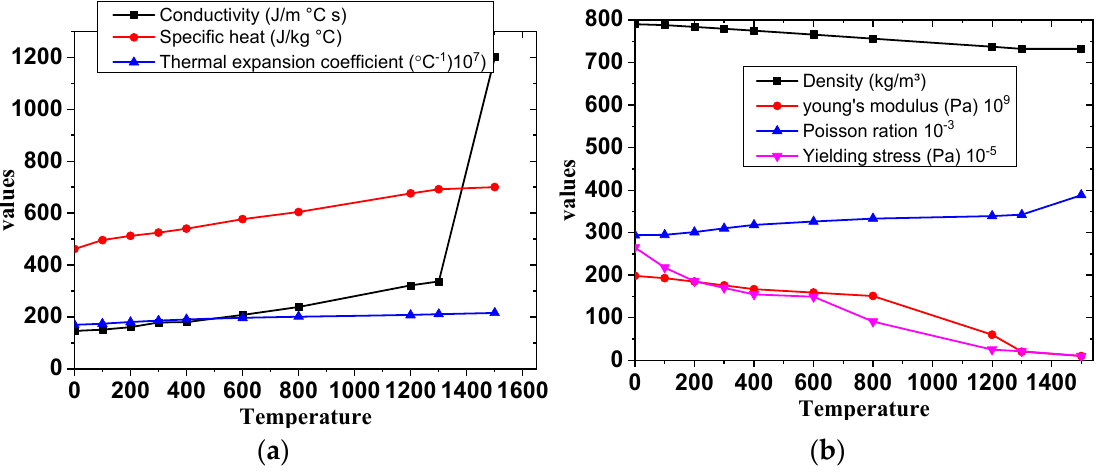
Figure 2. Properties of stainless steel SUS304: ( a ) Thermal properties, ( b ) Mechanical properties.